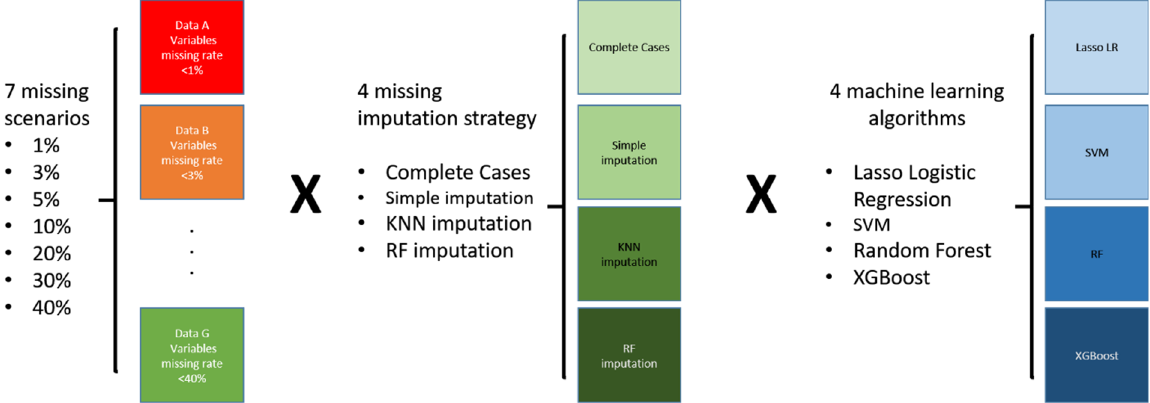
Figure 1. Scenarios considered.